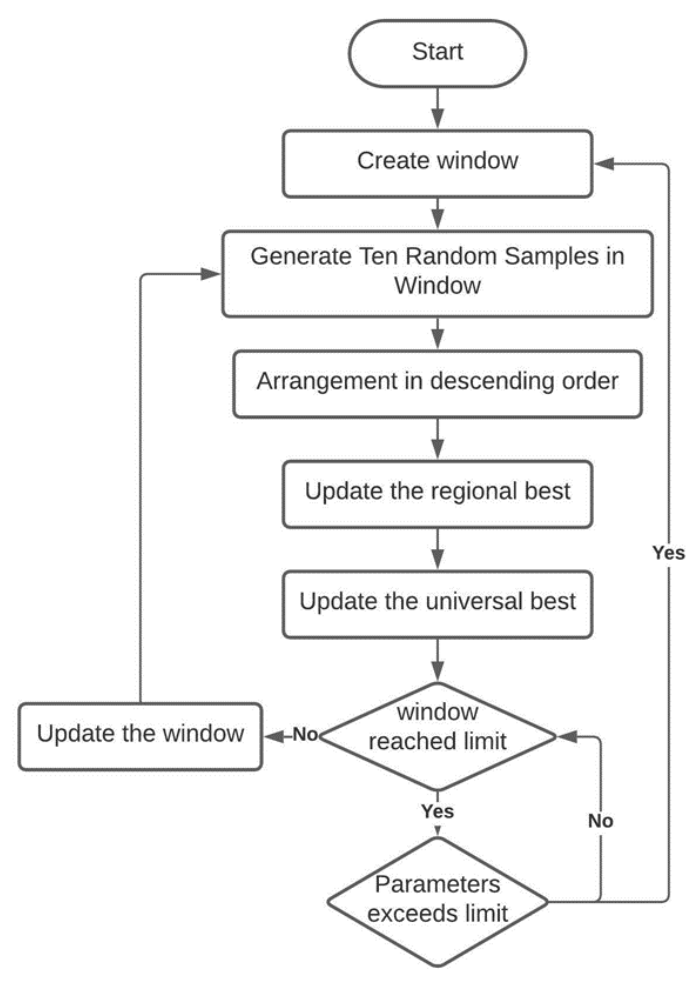
Figure 3. Flowchart of the optimized ten check